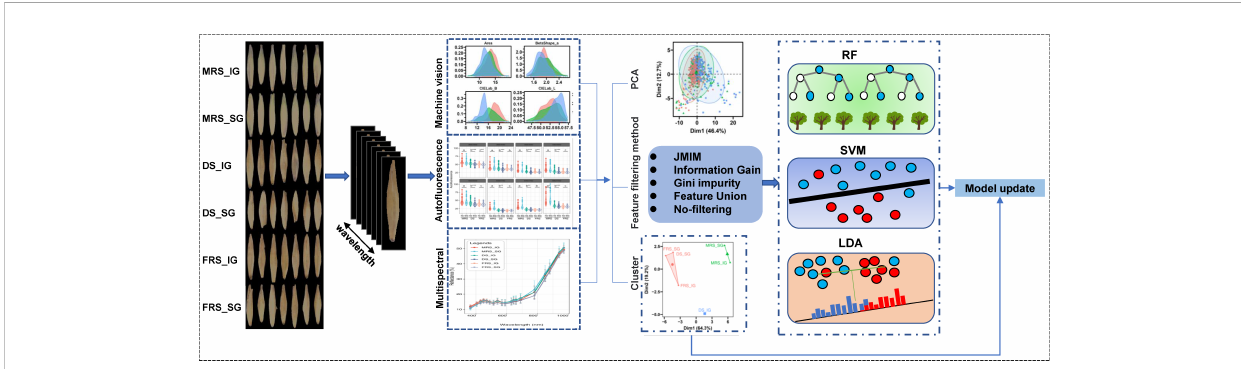
FIGURE 1 Technical route. RF, random forest; SVM, support vector machine; LDA, linear discriminant analysis. We obtained RGB images, multispectral images, and auto fl uorescence images of Siberian wild rye seeds at different maturity stages and grain positions using Vidoemeter equipment. Then, we segmented individual seeds from the background and extracted their morphological, multispectral, and auto fl uorescence features. Furthermore, we performed PCA and LDA exploratory analysis on the three types of features and their multi-source fusion data. We also selected three fi ltering algorithms, JMIM, information gain, and Gini impurity, and set two controls (feature fusion and non- fi ltered features) to fi lter the multi-source fusion data. Based on the fi ltered features, we built SVM, RF, and LDA models to differentiate different seed maturity stages. Additionally, we applied k- means clustering to reclassify seeds based on their maturity stages and grain positions, and updated the model to further improve its classi fi cation